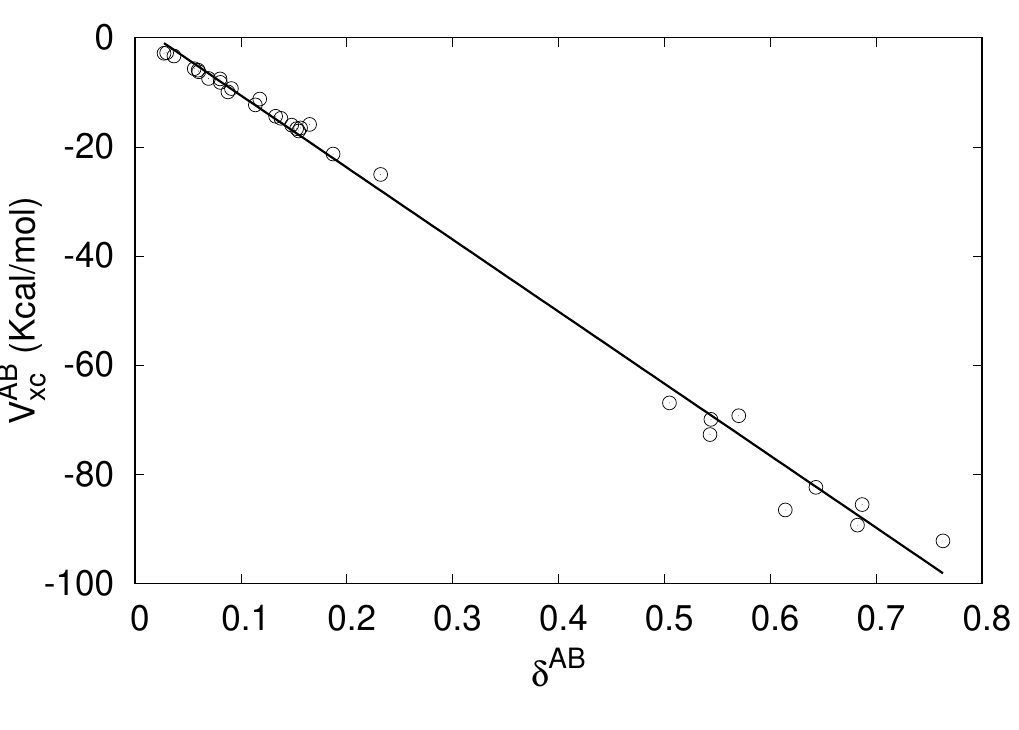
Figure 2. V AB xc versus δ AB values for the complexes of Table